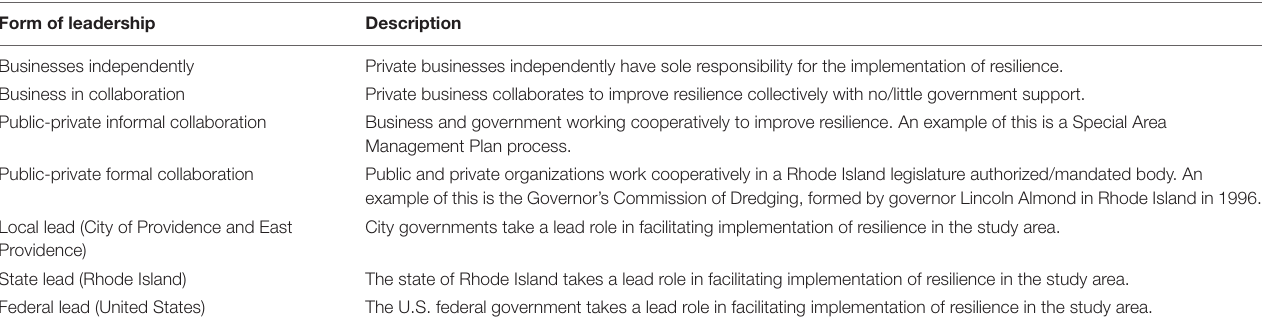
TABLE 2 | Organizational leadership structures for climate